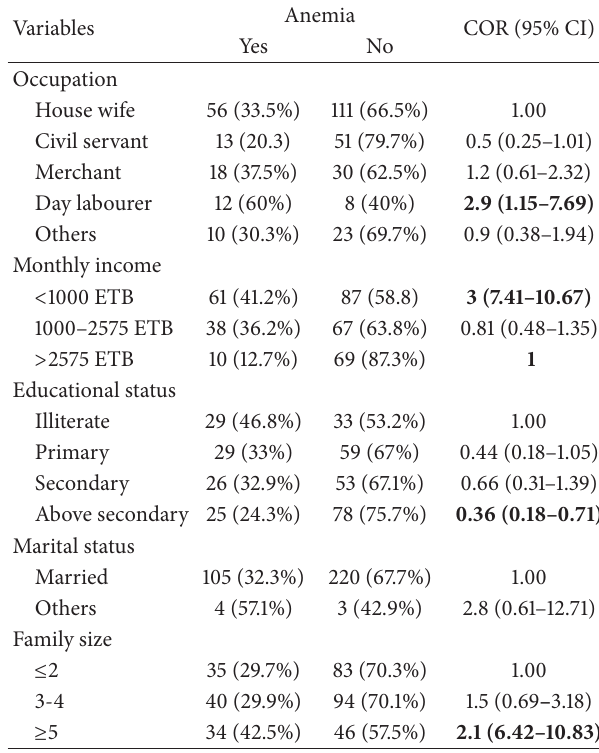
Table 4: Sociodemographic factors associated with anemia in pregnancy among ANC attendees in government health institutions of Arba Minch town from February to April 2015 ( 𝑛 = 332